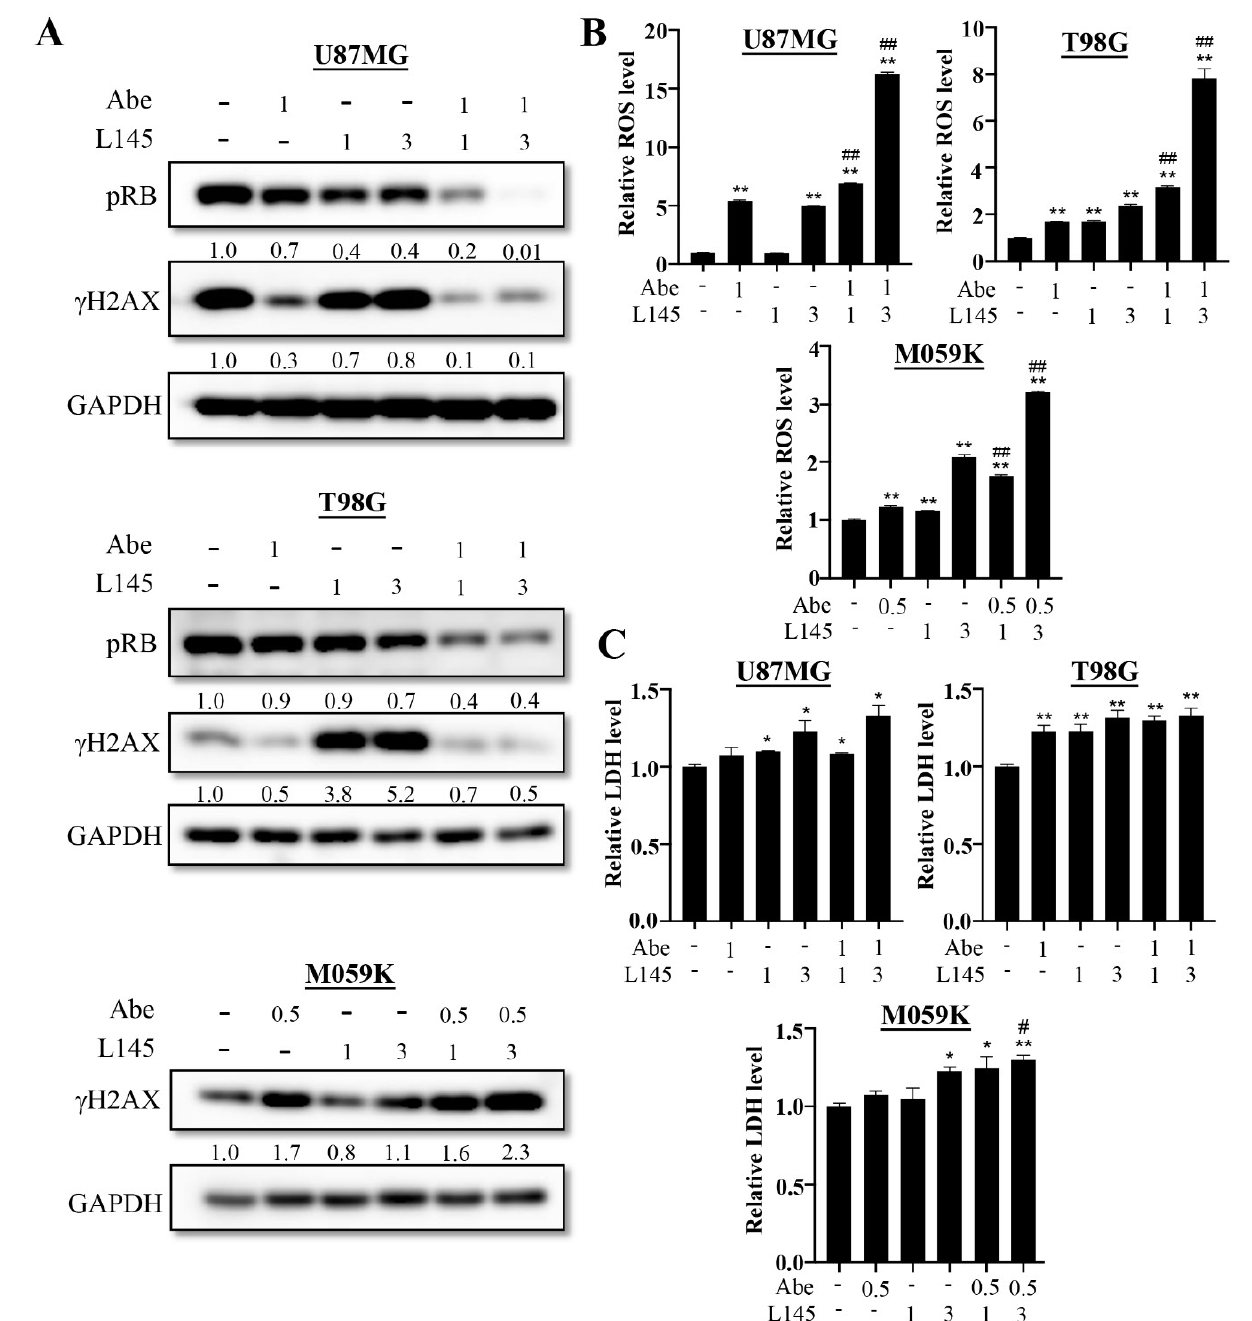
Figure 6. Effects of drug combinations on the U87MG, T98G and M059K cells. ( A ) The three cancer cells were treated with abemaciclib (μM) in the absence or presence of the indicated concentrations of MPT0L145 (μM) for 72 h. Protein lysates were subjected to Western blot analysis for detection of the levels of phosphorylated RB and γH2AX. ( B ) The three cancer cells were treated with abemaciclib (μM) in the absence or presence of indicated concentrations (μM) of MPT0L145 for 72 h. Accumulation of intracellular ROS levels were measured by luminometer. The luminescence units were normalized by the absorption value (O.D. 570 nm) from the MTT assay representing cell amounts, and fold changes were calculated and presented as the mean ± SD. (* p < 0.05, ** p < 0.01 compared to control group, # p < 0.05, ## p < 0.01 compared to indicated concentrations of abemaciclib) ( C ) The three cancer cells were exposed to abemaciclib (μM) in the absence or presence of indicated concentrations (μM) of MPT0L145 for 72 h. The supernatant was collected and subjected to LDH analysis. Data are presented as the mean ± SD. (* p < 0.05, ** p < 0.01 compared to control group, # p < 0.05, ## p < 0.01 compared to in- dicated concentrations of abemaciclib).